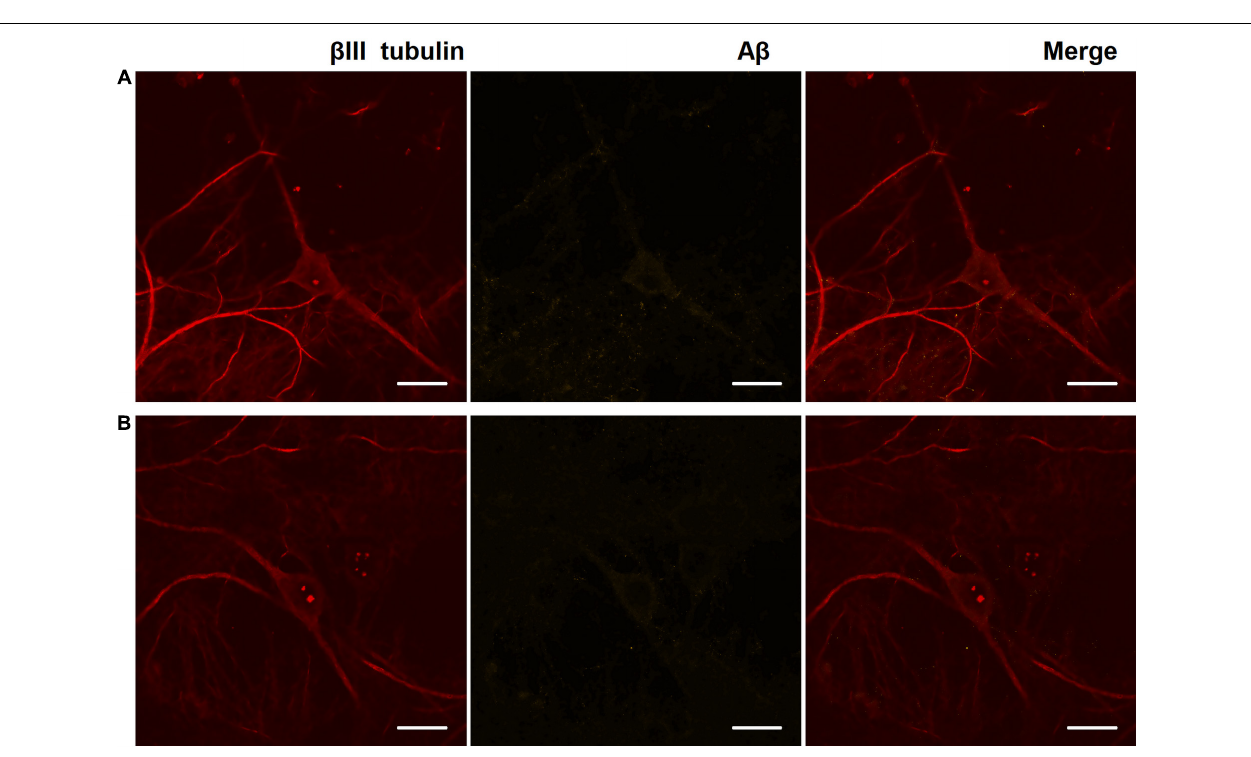
FIGURE 3 | Representative confocal images of immunocytochemical staining of primary hippocampal cultures on DIV 28. (A) Primary hippocampal cultures obtained from C57BL/6 murine embryos. (B) Primary hippocampal cultures obtained from 5xFAD murine embryos. Red: fluorescence channel of β III tubulin (neuronal microtubule marker); yellow: fluorescence channel of A β . Scale bar – 20 µ m. The level of A β expression did not change significantly.